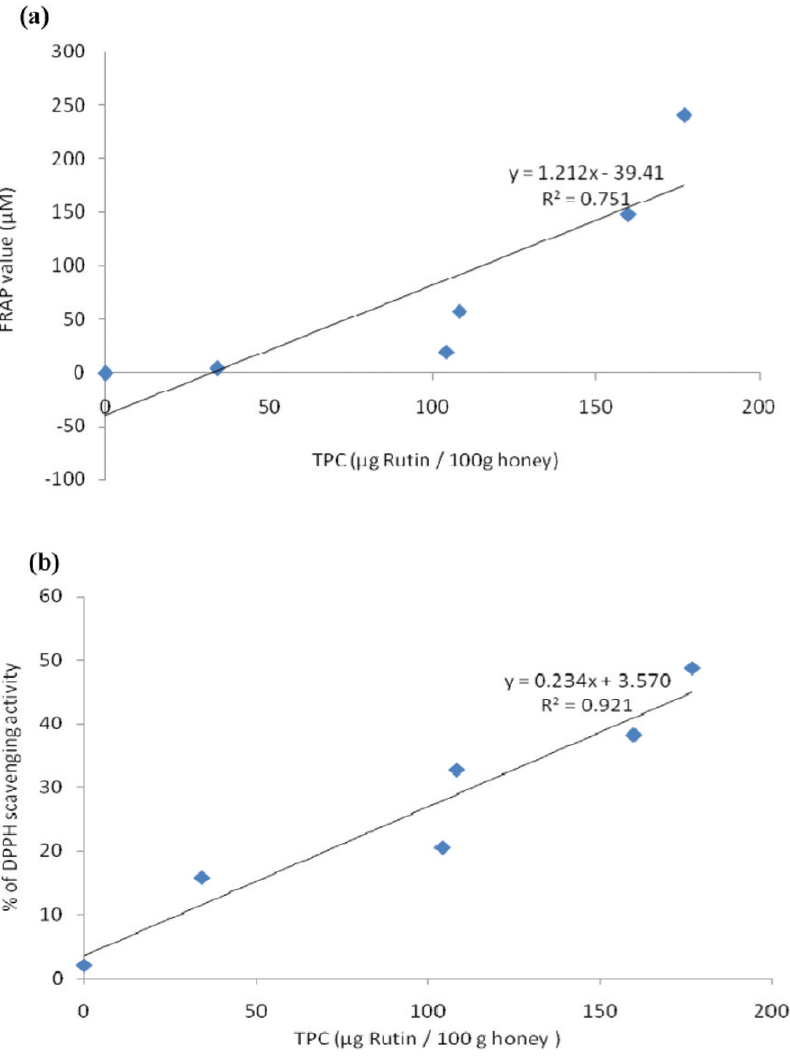
Figure 1 - A) Correlation between the total phenolic content (TPC) and ferric reducing/antioxidant power (FRAP value) of manuka honey. B) Correlation between the total phenolic content and radical scavenging activity (% inhibition) using the DPPH of manuka honey.